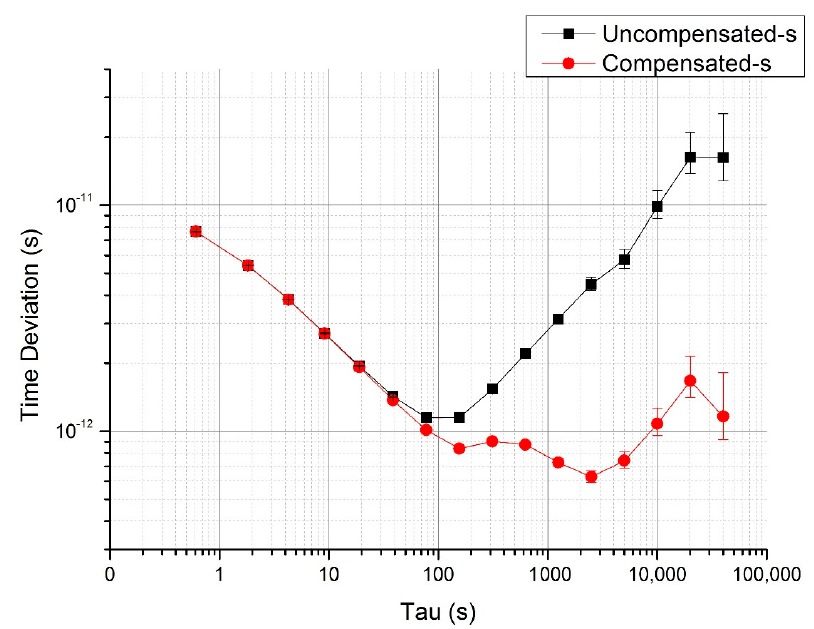
Figure 5. Time deviation (TDEV) before and after compensation in the temperature stable period.